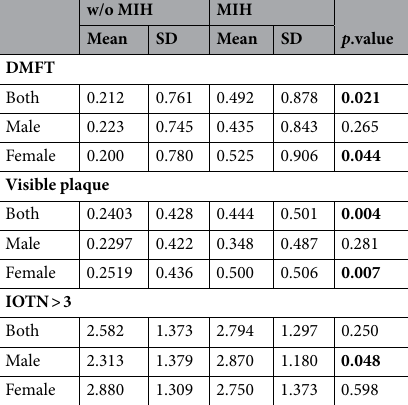
Table 5. Significance of the difference in DMFT, visible plaque and IOTN > 3 between groups without/with MIH. Significant values are in